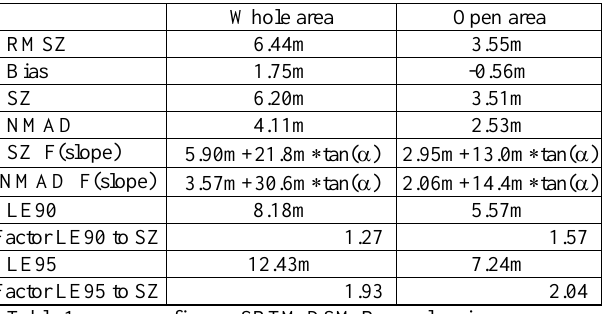
Table 1: accuracy figures SRTM DSM Pennsylvania